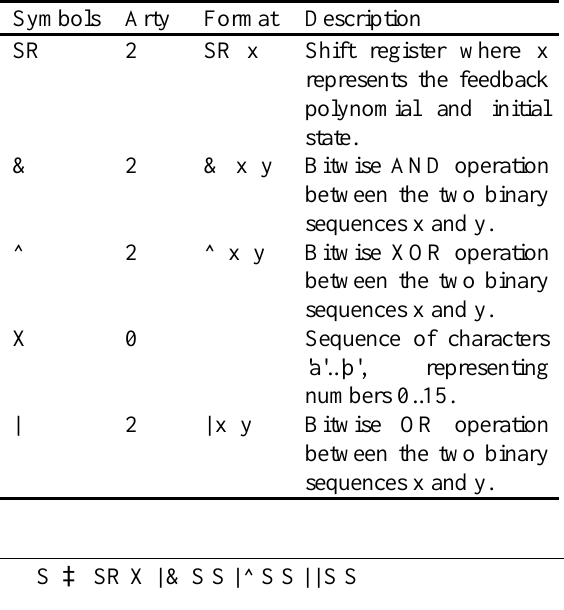
Table 1. The function library used